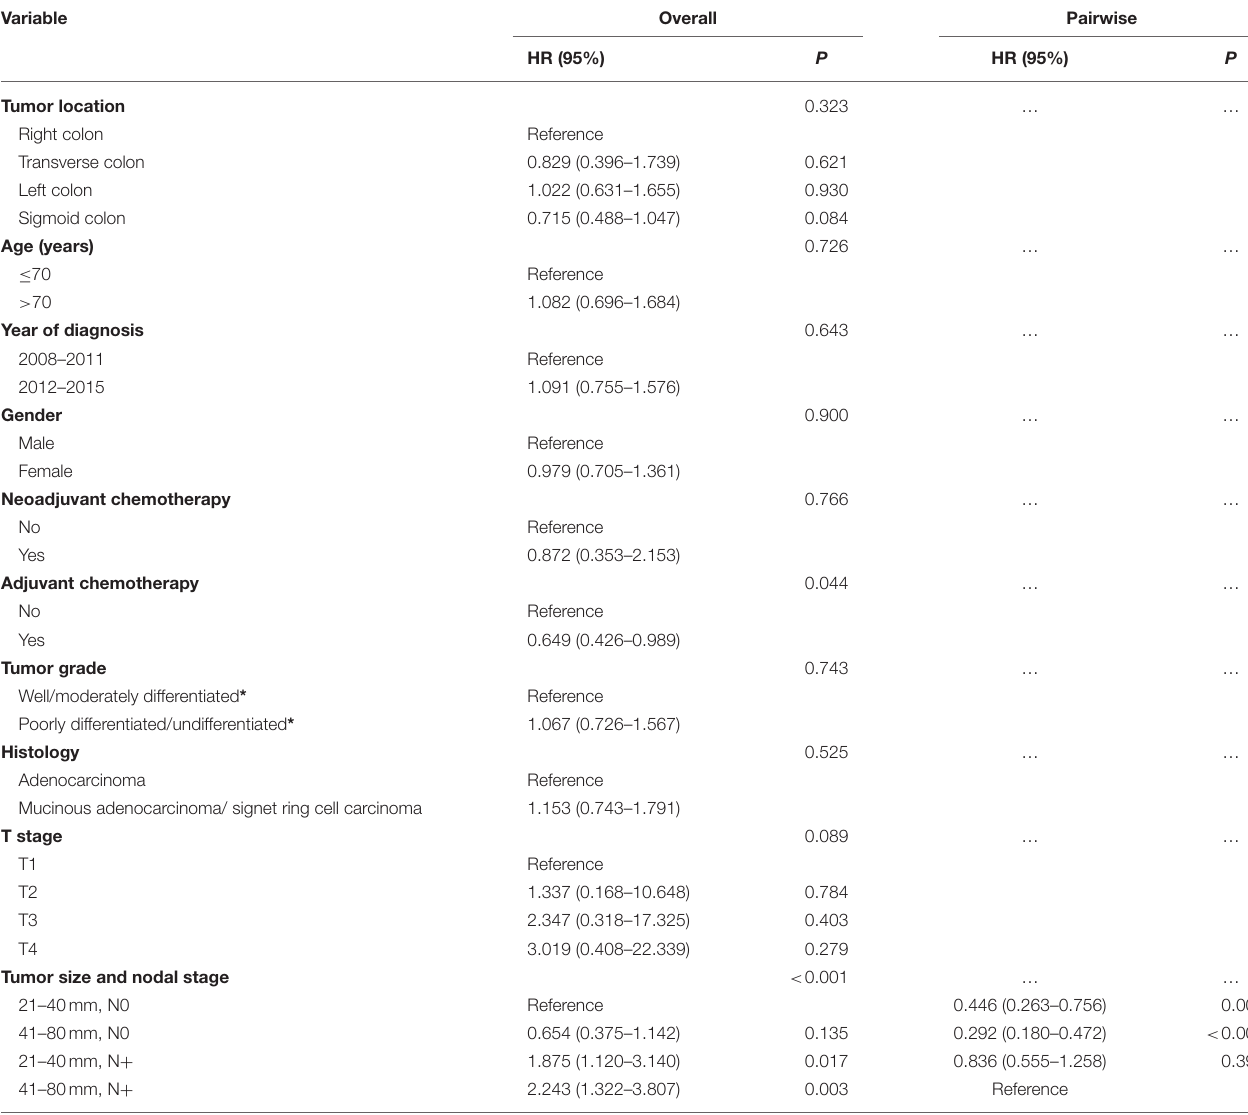
TABLE 2 | Multivariate Cox regression analyses of CSS in FUSCC